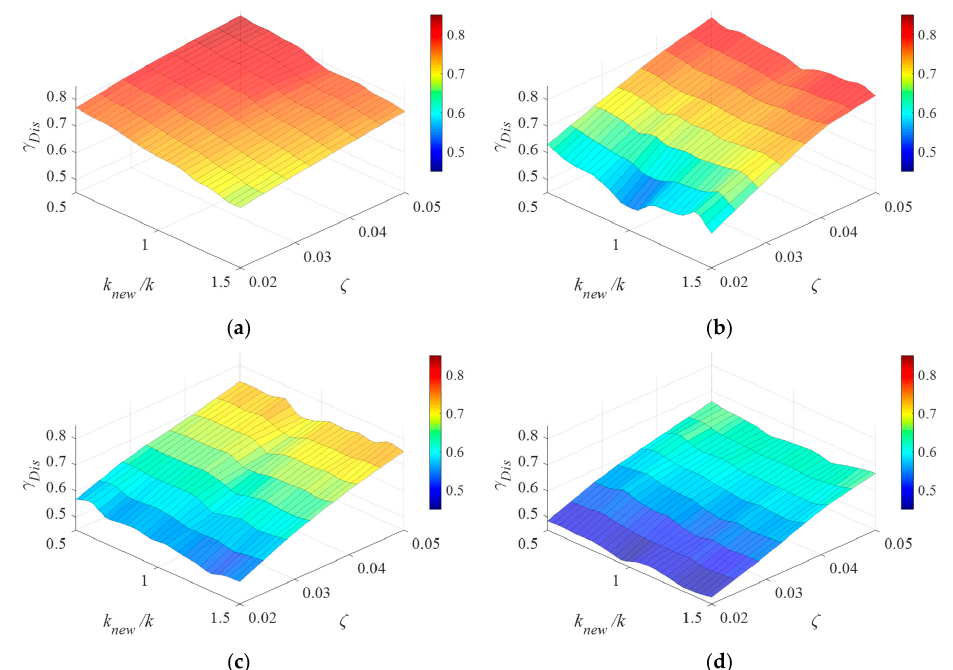
Figure 11. Sensitivity analysis of γ Dis with variation of the structural circular frequency for κ = 0.50 and λ = 1.00 with ( a ) µ = 0, ( b ) µ = 0.10, ( c ) µ = 0.25, and ( d ) µ = 0.40.